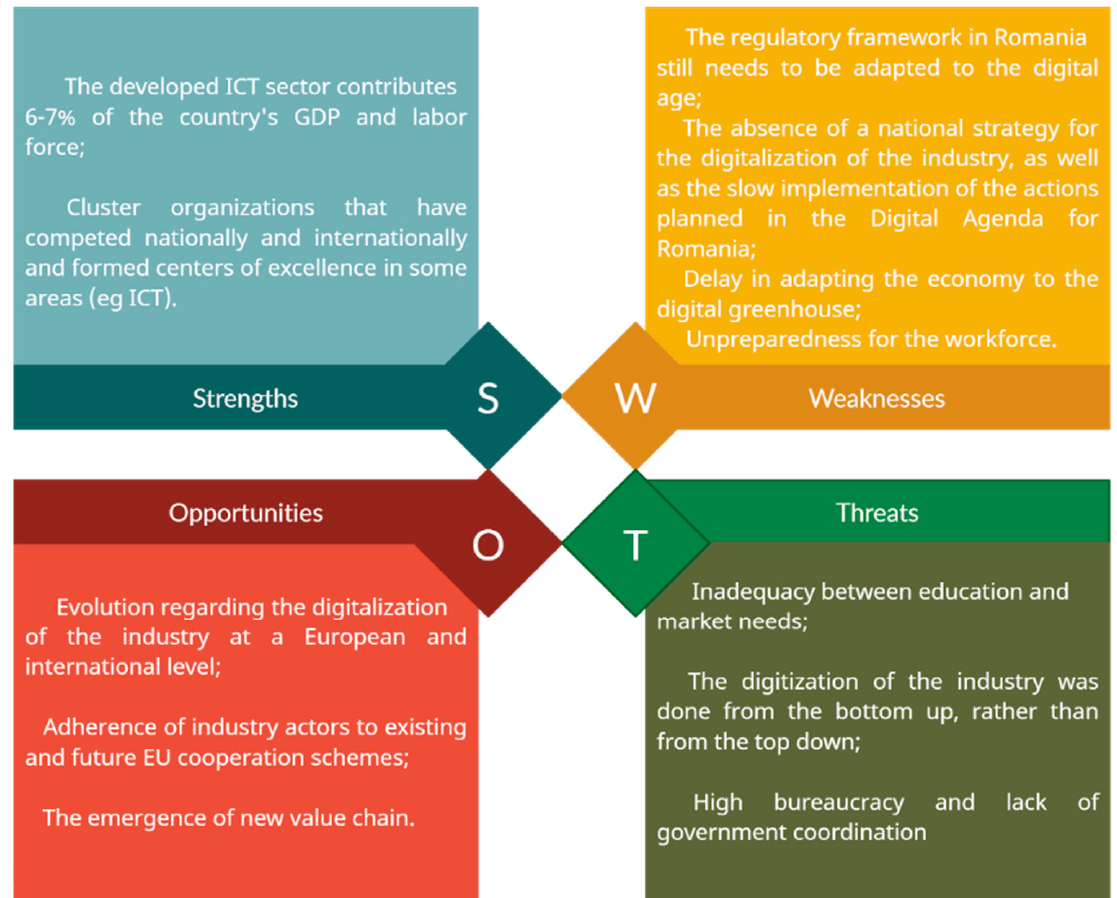
Figure 8. SWOT analysis of digitization in Romania.